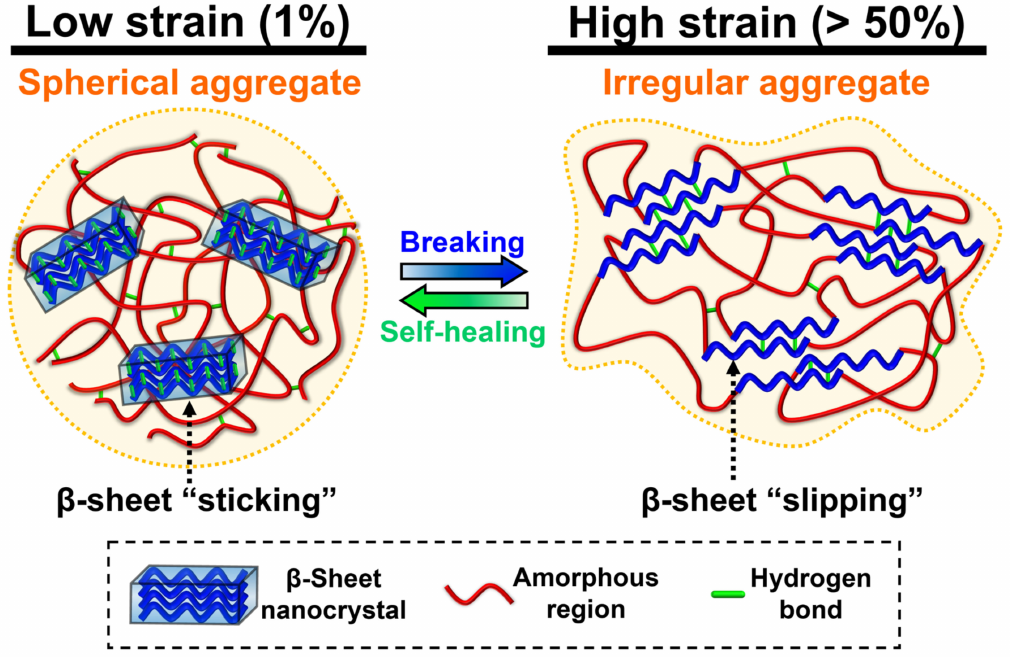
Figure 6. The hypothetical self-healing mechanism of the recombinant spider silk under low strain (1%) and high strain